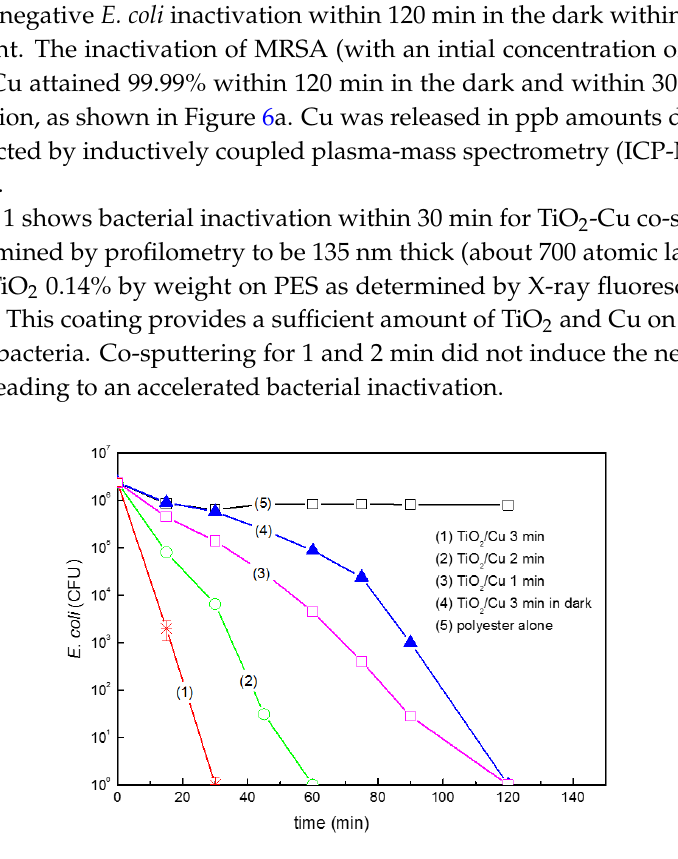
Figure 13. ( a ) Effect of the initial bacterial concentration of MRSA loss of viability on: (1) Unsputtered PES and by co ‐ sputtered TiO 2 /Cu ‐ PES for 3 min tested in the dark: (2) 10 8 CFU/mL, (3) 10 6 CFU/mL and (4) 10 5 CFU/mL. ( b ) Effect of light intensity on MRSA loss of viability on co ‐ sputtered TiO 2 /Cu ‐ PES for 3 min under: 1.01, 2.85, and 4.65 mW/cm 2 .